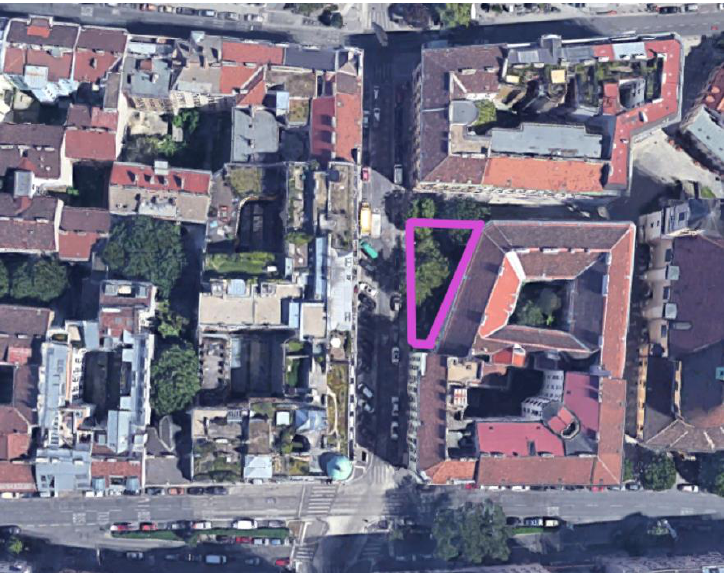
Figure 5. Location of the Salatpiraten community garden in Vienna, Austria — a trapezoid parcel of land along Kirchengasse, [compiled by A. Tofiluk, based on site visit (09.2018) and online source: www.google.pl/maps (accessed on 24 May 2021)].